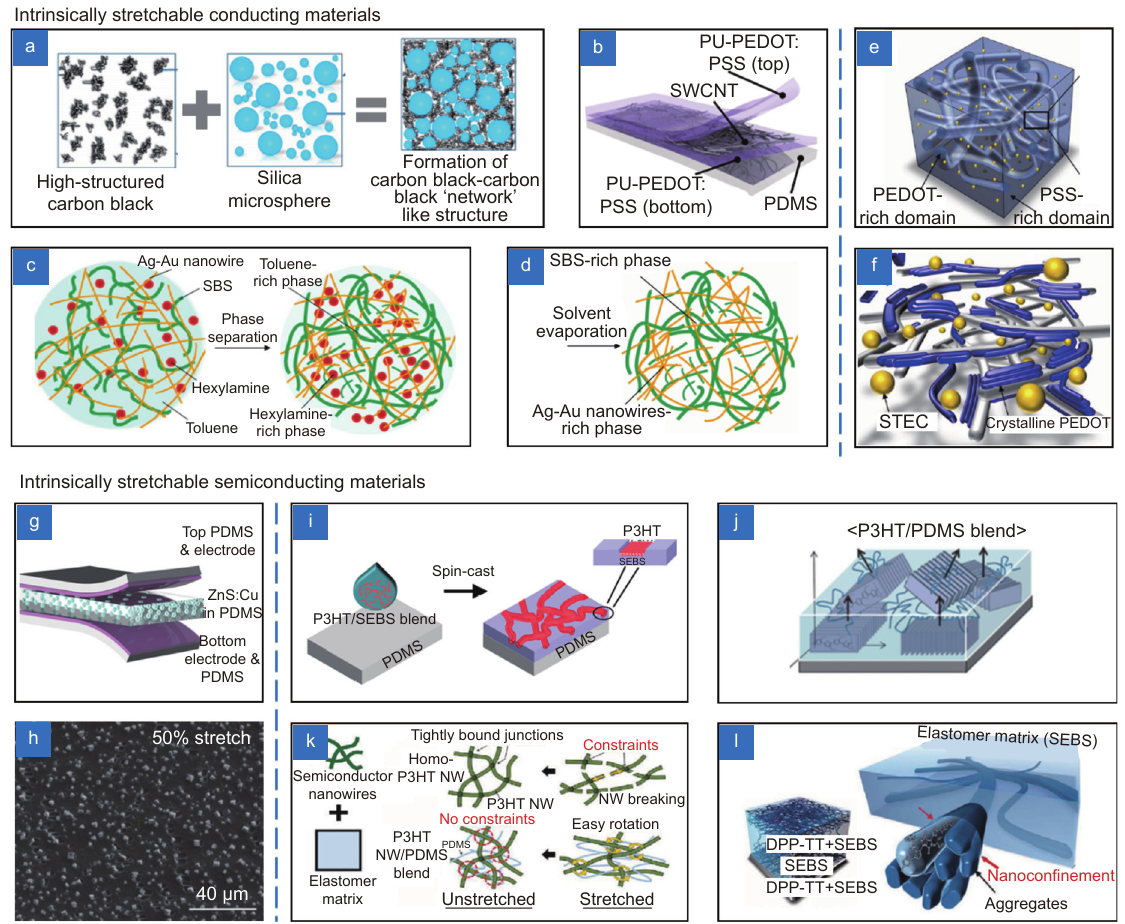
Fig. 3 | Various conducting/semiconducting nanocomposites with intrinsic stretchability. Intrinsically stretchable conducting nanocompos- ites based on: ( a ) CB and silica particles; ( b ) SWCNTs and PU-PEDOT:PSS; ( c , d ) Ag-Au NWs and SBS; and ( e , f ) PEDOT:PSS incorporated with STEC enhancer. Intrinsically stretchable semiconducting nanocomposites based on: ( g ) ZNS:Cu microparticles and PDMS; ( h ) MAPbBr3 mi- croparticles and PEO; ( i – k ) P3HT nanofibers and SEBS; and ( l ) DPPT-TT nanofibers and SEBS. Figure reproduced from: (a) ref. 121 , (b) ref. 150 , American Chemical Society; (c, d) ref. 111 , Springer Nature; (e, f) ref. 125 , under a Creative Commons Attribution-NonCommercial 4.0 International License; (g) ref. 151 , (i) ref. 141 , (j, k) ref. 142 , John Wiley and Sons; (l) ref. 143 , American Association for the Advancement of